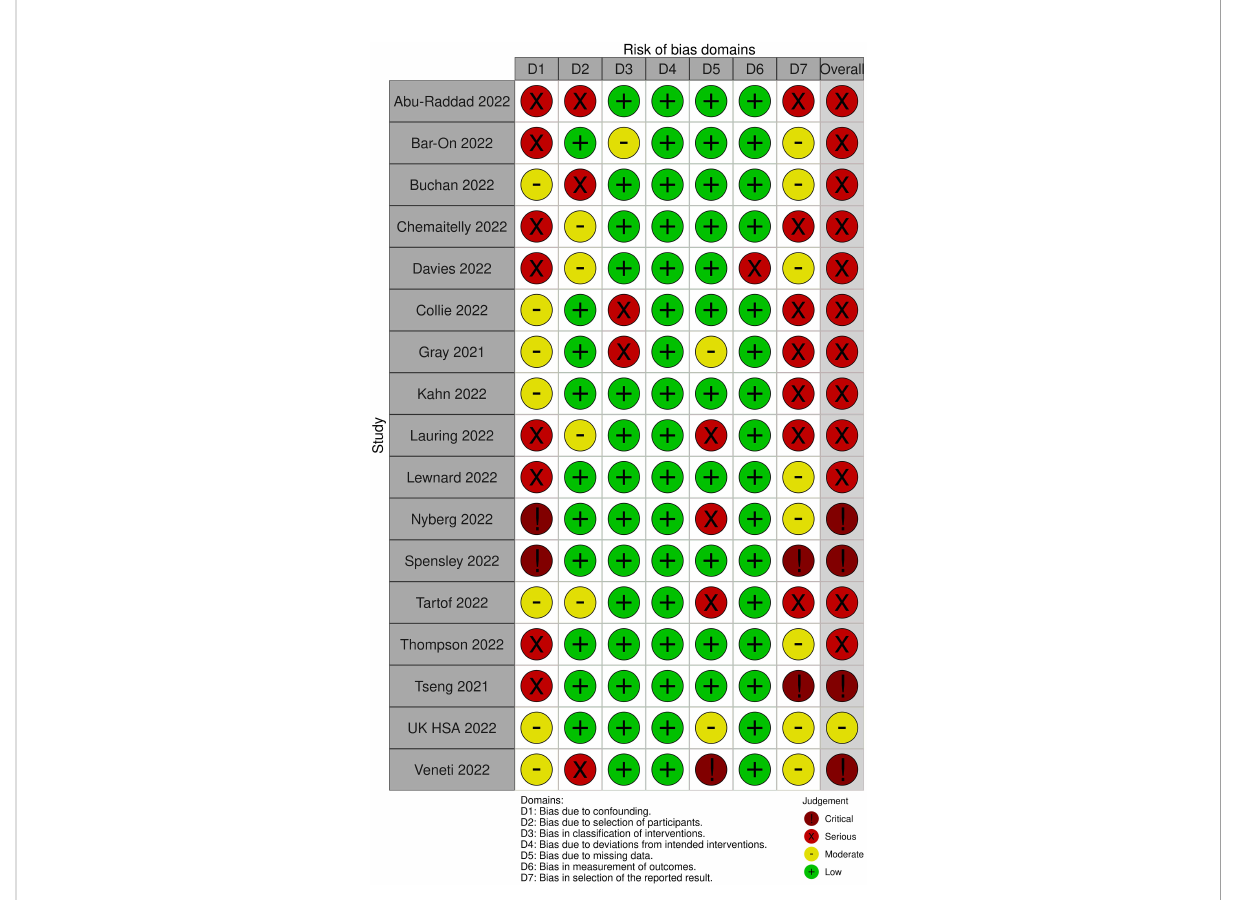
FIGURE 7 Risk of bias assessments for the outcome "severe COVID-19" due to SARS-CoV-2 infection of the Omicron